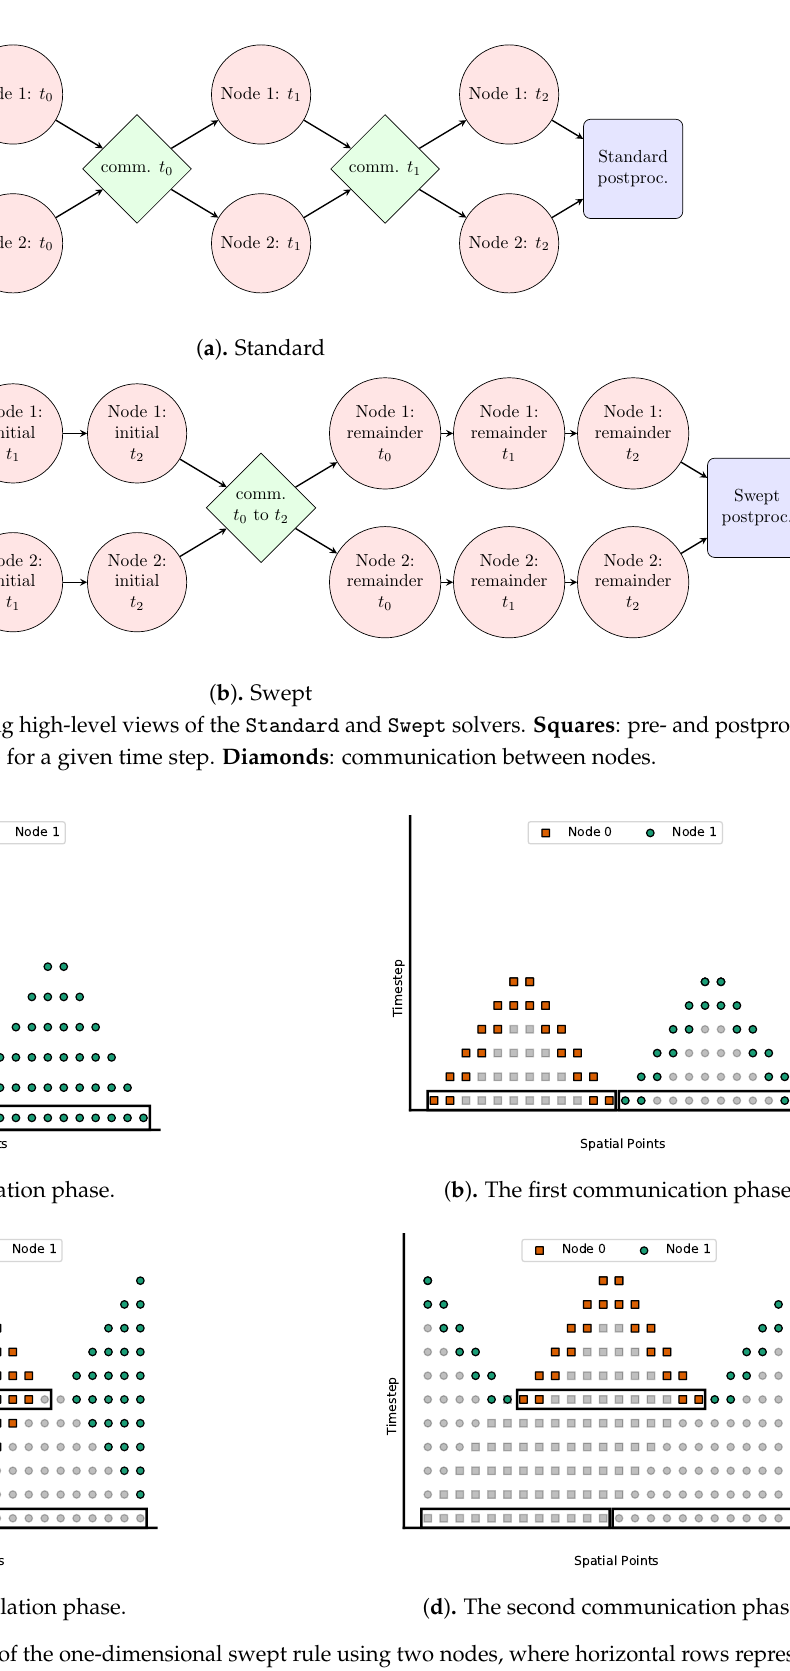
Figure 2. The first four operations of the one-dimensional swept rule using two nodes, where horizontal rows represent the spatial grid and moving up vertically represents advancing time